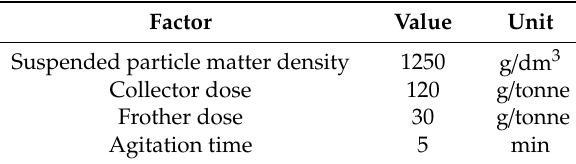
Figure 2. Scheme of flotation experiments. Table 1. Characteristics of flotation process